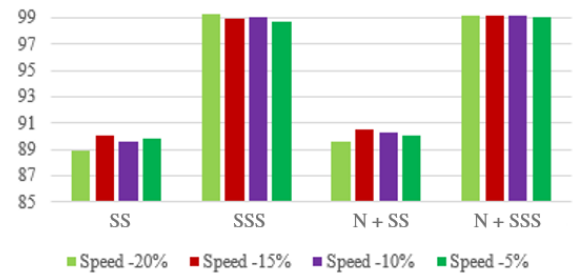
Figure 6. Results for synthetic datasets, Set 1 Speed modifications.